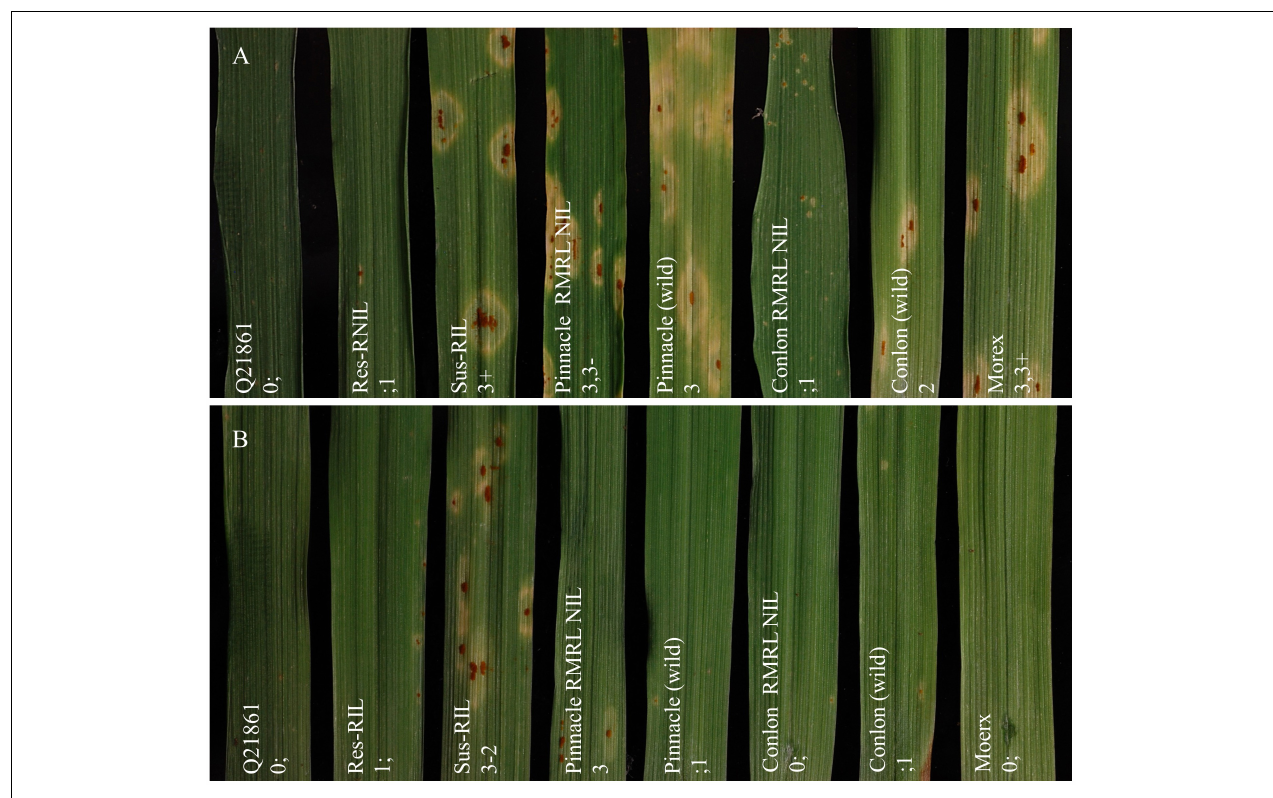
FIGURE 1 | Seedling assay using Puccinia graminis f. sp. tritici ( Pgt ) races QCCJB and HKHJC. (A) Pgt race QCCJB is avirulent on barley lines containing RMRL and (B) Pgt race HKHJC is avirulent on lines containing Rpg1 . From left: Q21861 (RMRL+, Rpg1 +), Res-RIL [Resistant F 4 : 5 Pinnacle RMRL-NIL/Q21861 RIL (RMRL+, Rpg1 +)], Sus-RIL [Susceptible F 4 : 5 Pinnacle RMRL-NIL/Q21861 RIL (RMRL+, Rpg1 +)], Pinnacle RMRL-NIL (RMRL+, Rpg1 +), Pinnacle wild type (RMRL-, Rpg1 +), Conlon RMRL-NIL (RMRL+, Rpg1 +), Conlon wild type (RMRL-, Rpg1 +), Morex (RMRL-, Rpg1 +). A 0–4 modified scale for barley was used to score the disease response (Stakman et al., 1962; Steffenson et al.,